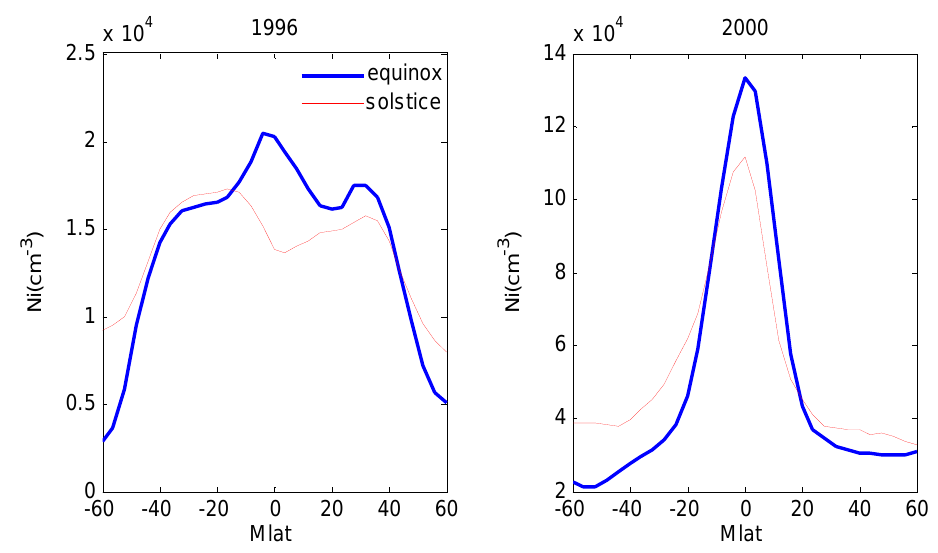
Fig. 6. Comparison between the nighttime average value of two equinox months and two solstice months for solar minimum 1996 and solar Figure 6 . Comparison between the nighttime average value of two equinox months maximum and two solstice months for solar minimum 1996 and solar maximum 2000.